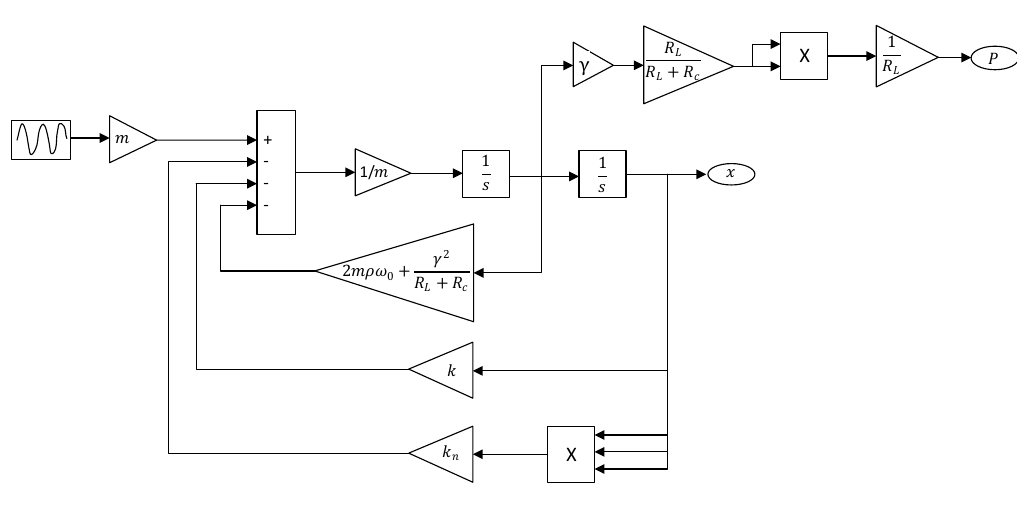
Figure 3. Simulink model.